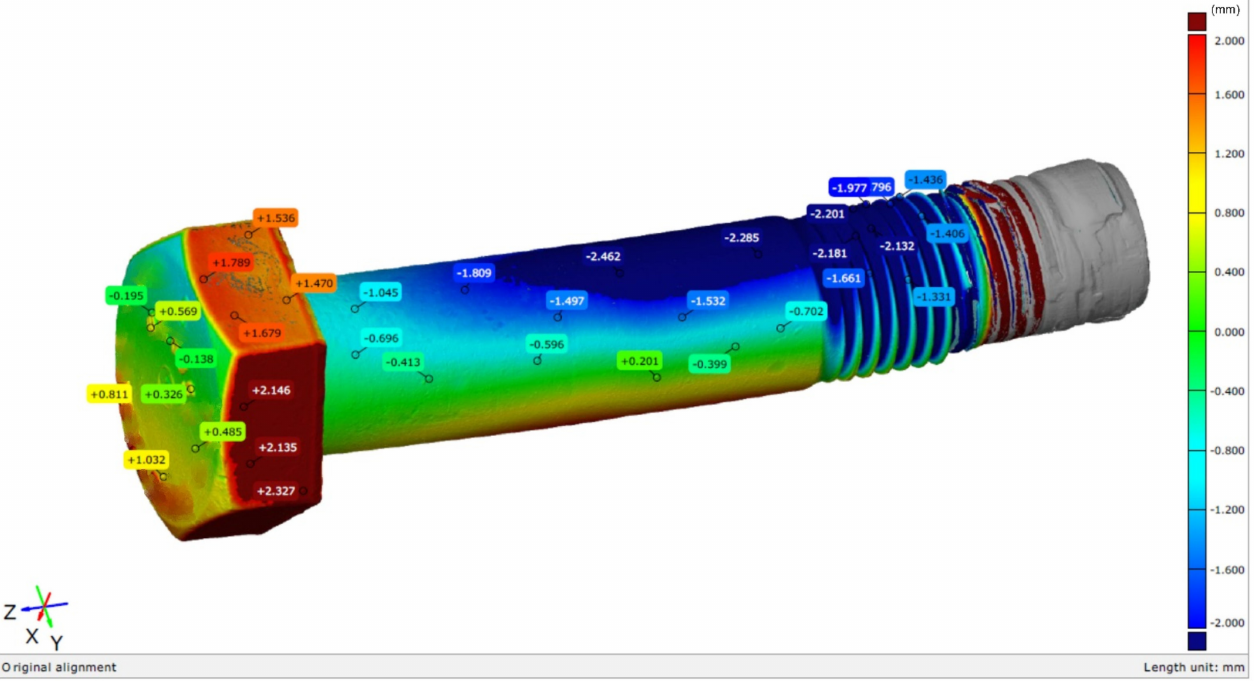
Figure 2. Colored map of deviations for the S1